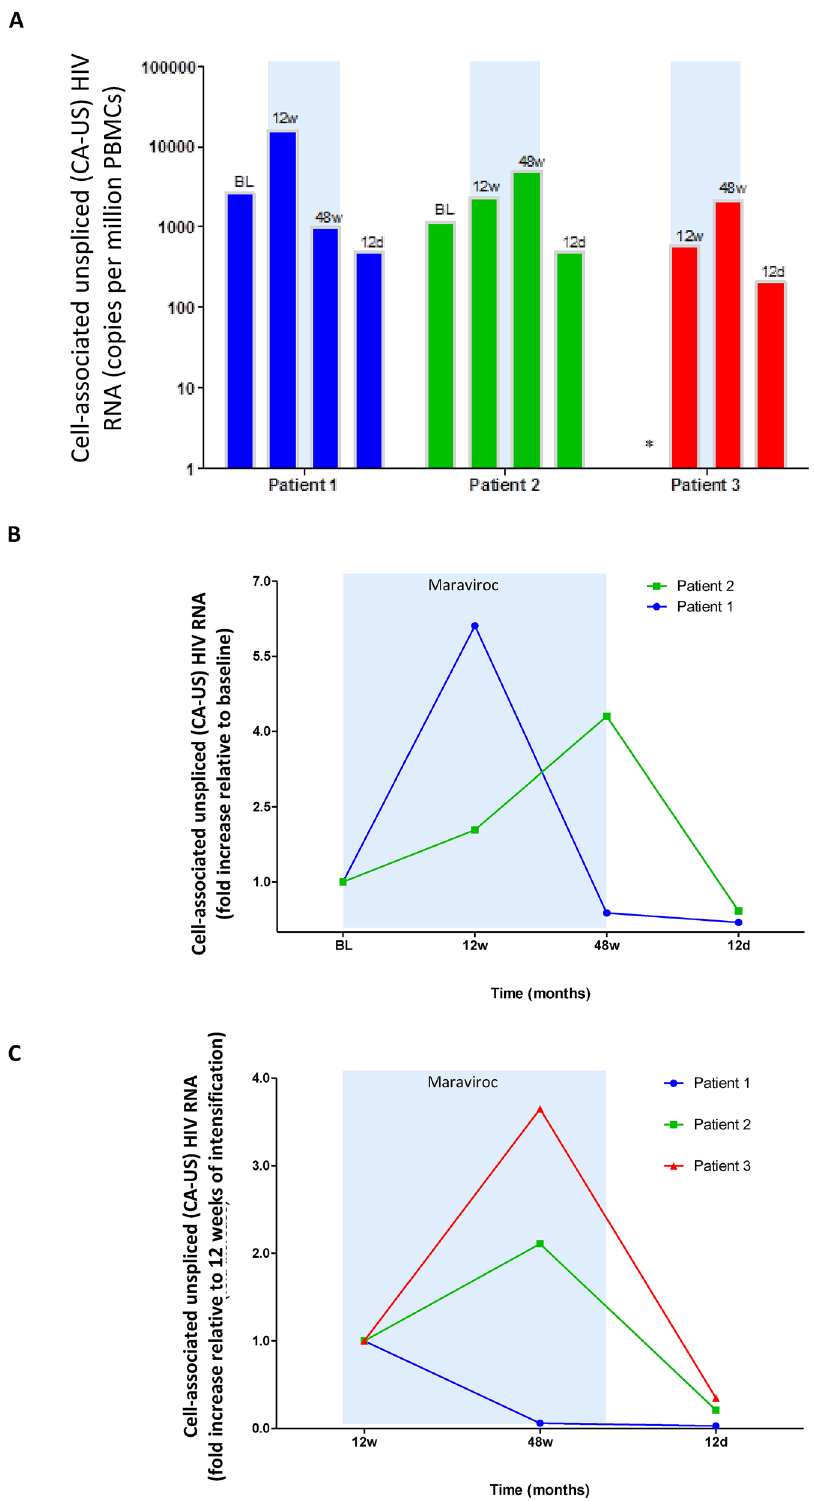
Figure 1. Levels of cell associated unspliced HIV RNA in PBMCs isolated from HIV-infected patients on ART who were under intensification with maraviroc. ( A ) Copies per million peripheral blood mononuclear cells (PBMCs), ( B ) relative fold change with respect to baseline and ( C ) relative fold change with respect to 12 weeks of treatment intensification. The blue shaded box shows the time on maraviroc intensification. BL, baseline; 12w, 12 weeks on maraviroc; 48w, 48 weeks on maraviroc; 12d, 12 weeks after discontinuation of maraviroc. *Baseline sample in patient 3 was not